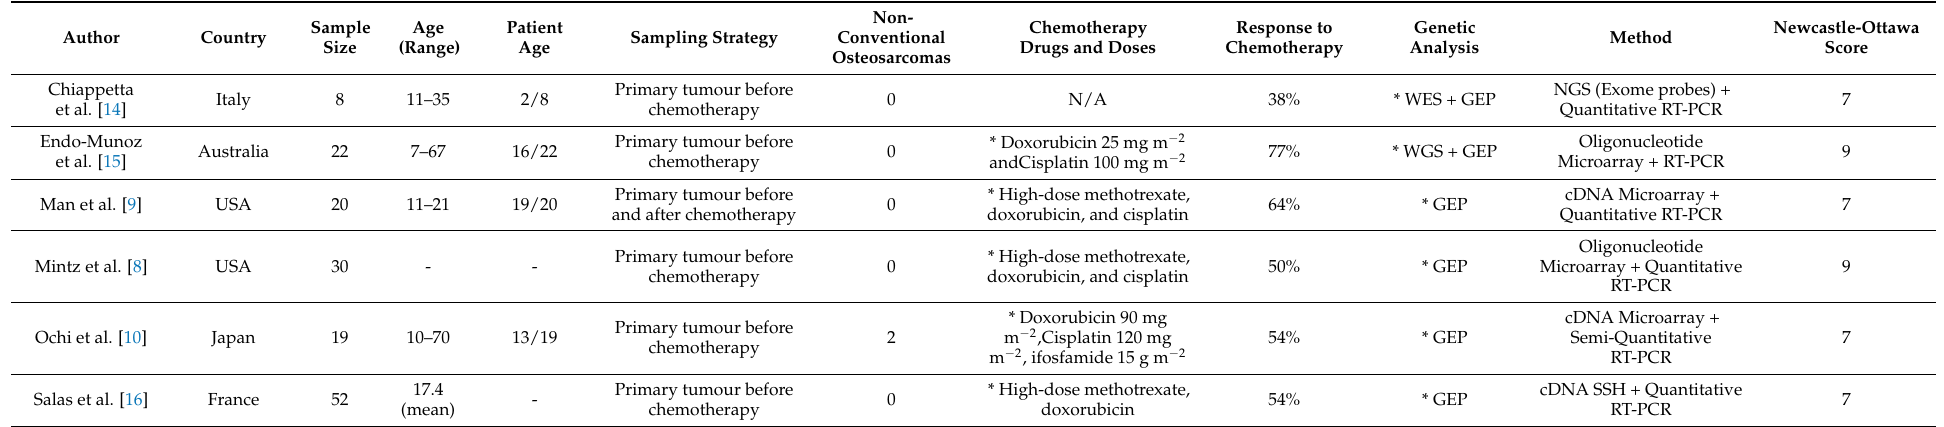
Table 1. Study characteristics and